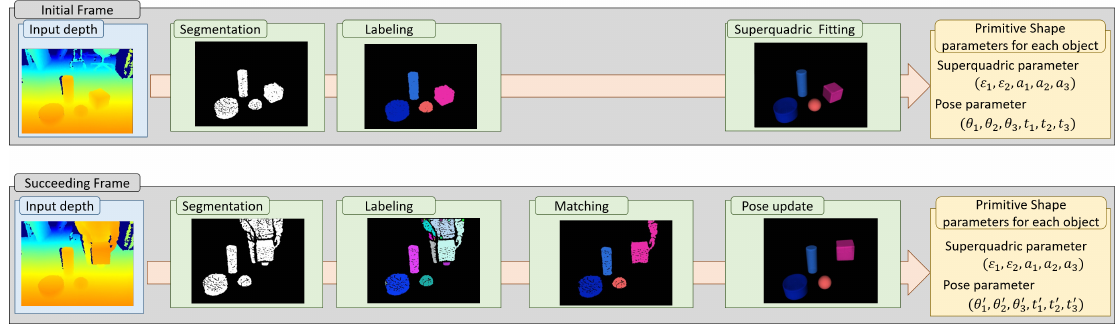
Figure 3. An overview of our proposed